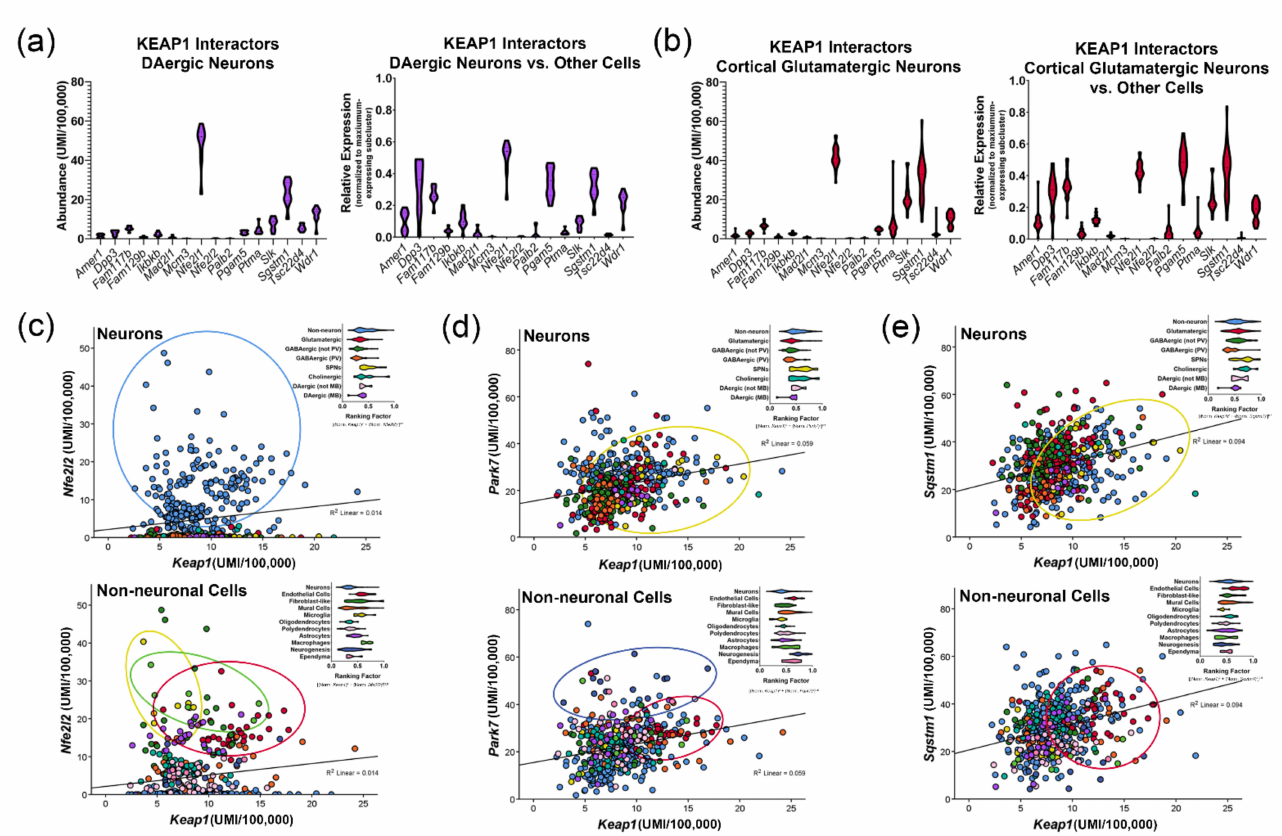
Figure 5. Data from Dropviz.org (accessed on 9 December 2021) [4] were mined to explore cell type-specific expression of KEAP1 interactors in DAergic neurons (relevant to therapeutic targeting in PD) ( a ), and in cortical glutamatergic neurons (relevant to therapeutic targeting of excitotoxicity in ALS) ( b ) in the neuroanatomical relationship between transcript abundance for Keap1 and Nfe2l2 ( c ), Park7 ( d ), and Sqstm1 ( e ). Values are expressed as UMI/100,000 in graphs and as “Ranking factor” for cell type-specific patterns of expression in figure insets. Ranking factors were generated by calculating the distance from the origin for each cell type using the equation [x2 + y2] 0.5 , where (x,y) represent UMI/100,000 values normalized to the highest expressing subcluster. Statistics are provided in Supplementary Table